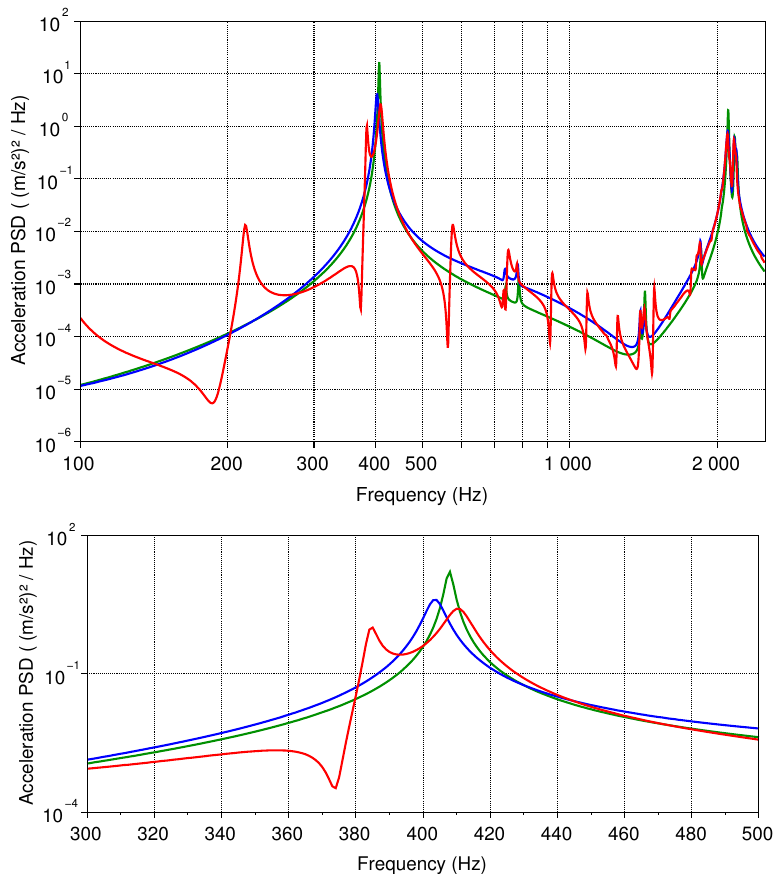
Figure 9. HB–2 structural response (acceleration PSD) at the center of the bottom, point (c) in Figure 6, simulated using the FEM model alone (green), the BEM subsystem of the external air volume (blue) and the BEM subsystem of both internal and external air volumes (red). A zoom in the vicinity of the first structural bottom mode (408 Hz) is